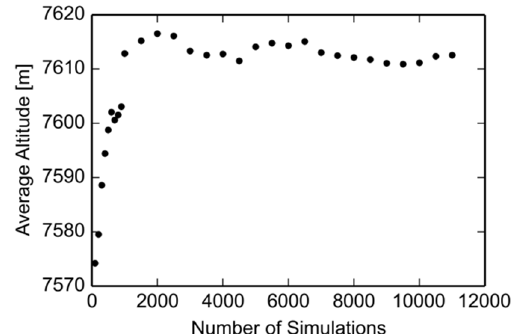
Figure 3. Averaged altitude at 50 NM with increasing number of simulation runs in the Monte Carlo simulation. The result converges to a constant value for more than 8000 runs.